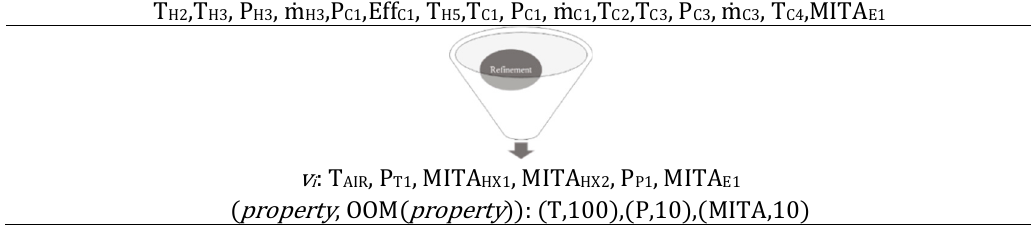
Figure 9. Exergy destruction and exergy losses distribution in the process case 1.